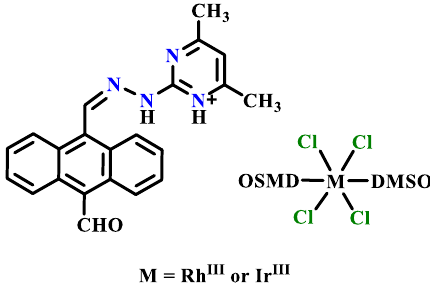
Figure 49. Two special ionic Rh(III)/Ir(III) complexes of p -aldehyde anthrachydrazone with a dime- thylpyrimidine side chain. dimethylpyrimidine side